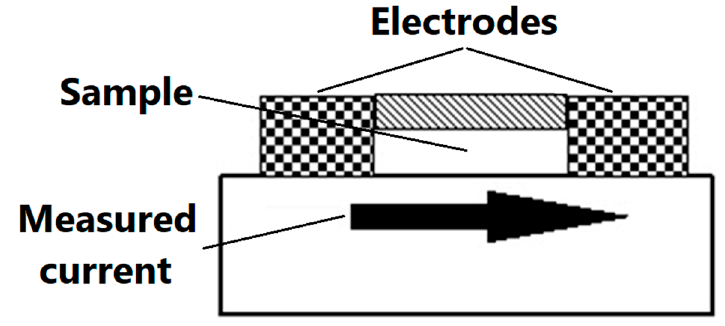
Figure 3. Scheme of the measurement of surface resistance.